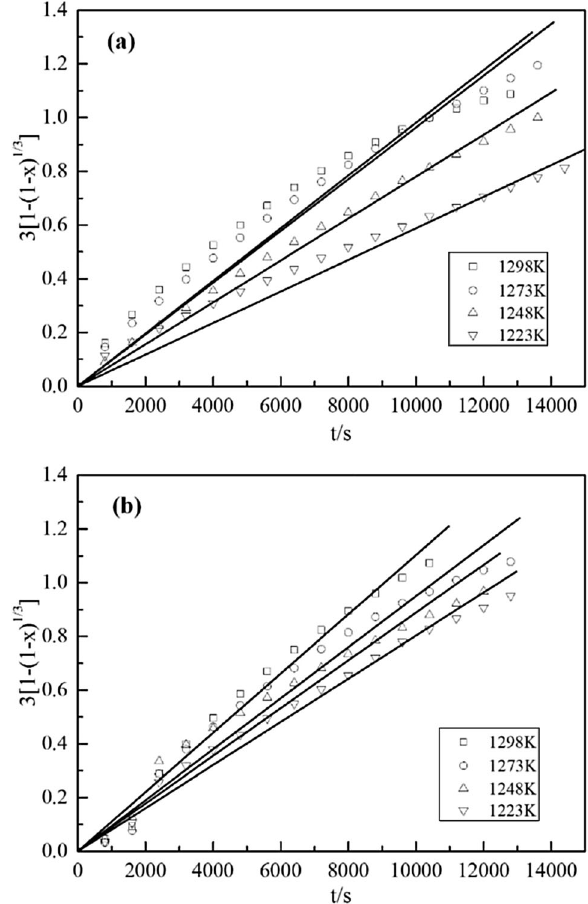
Fig. 6 Homogeneous model for a raw coke samples and b samples adsorbed Na 2 CO 3 at different temperatures